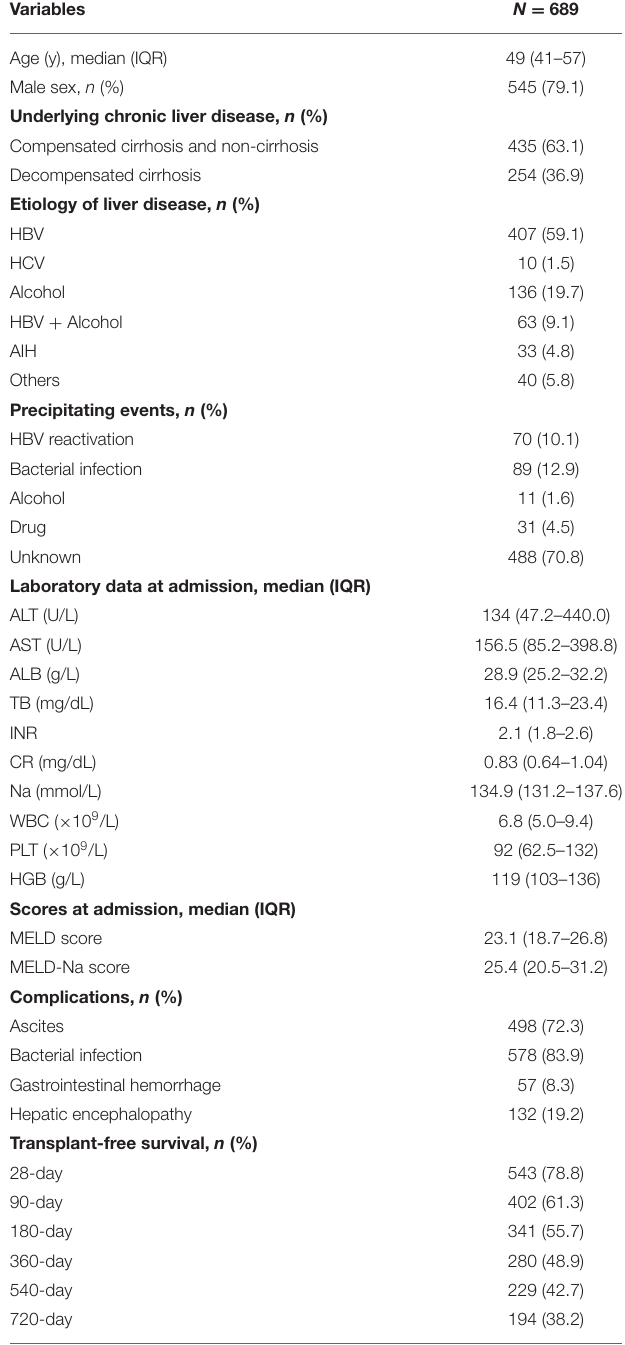
TABLE 1 | Baseline characteristics of the study